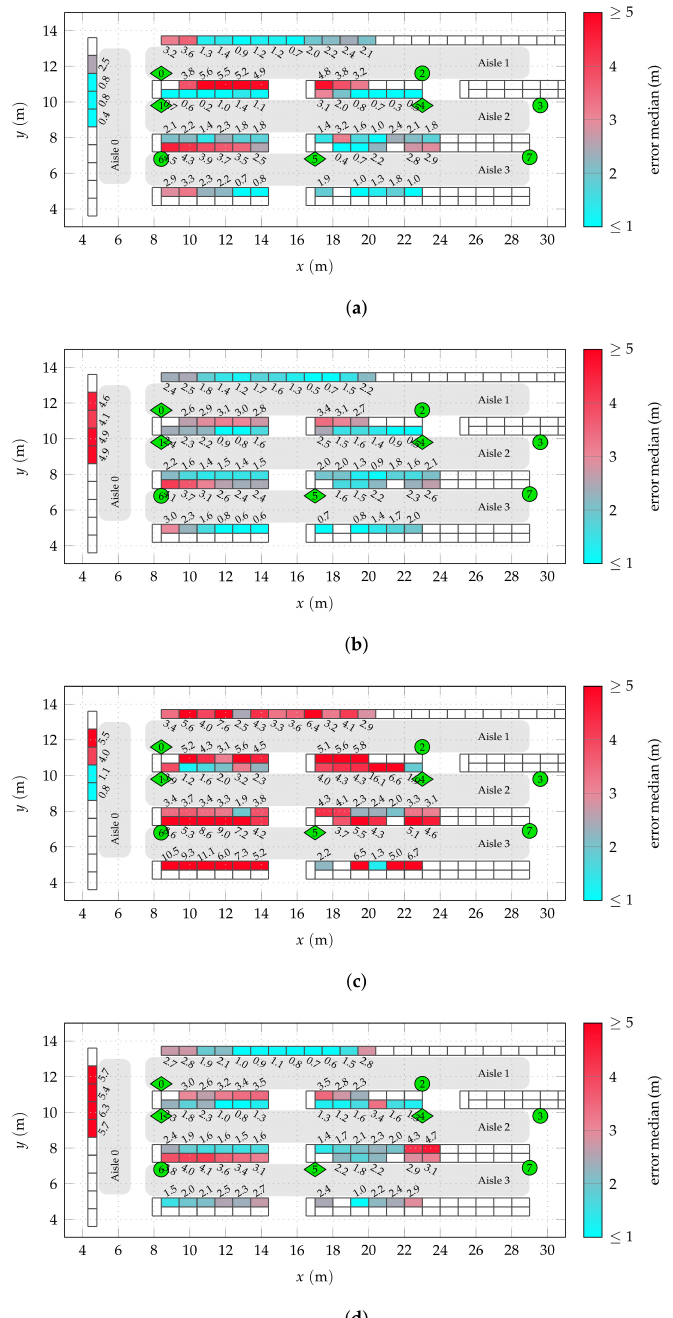
Figure 11. Shelf-wise median of the absolute positioning error for the described clustering approaches. In ( a ) and ( b ), both the TDoA and AoA information is used, in ( c ) and ( d ) only the AoA information. The clustering is based on actual node-to-node RSS measurements. ( a ) No clustering, TDoA+AoA. ( b ) N cl = 50, TDoA+AoA. ( c ) No clustering, AoA-only. ( d ) N cl = 50,